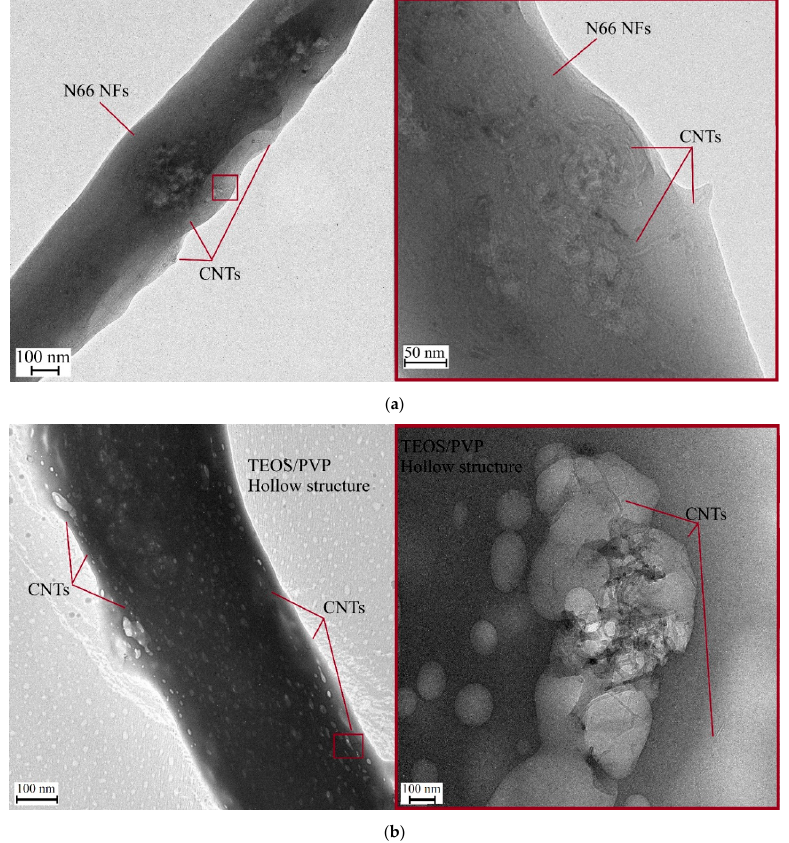
Figure 6. TEM images of electrospun nanofibers: ( a ) the hybrid nanofiber containing CNTs and nylon 66; ( b ) the hybrid nanofiber containing CNTs and TEOS/PVP.